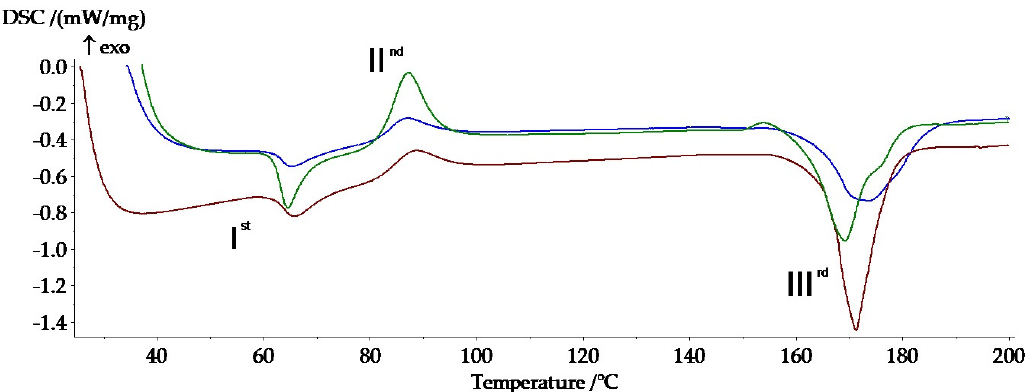
Figure 1. Highlighting the thermal behaviors of the tested samples: I st —first transformation; II nd —second transformation; III rd —third transformation; P3–143–9 passes (green), P6–6420–9 passes (blue), P9–136–9 passes (red).